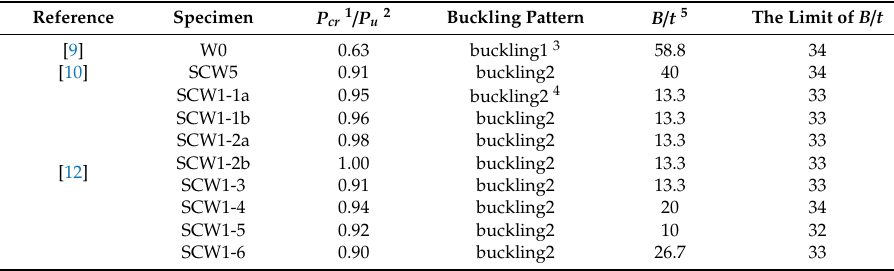
Table 1. The influence of B / t on local buckling of steel